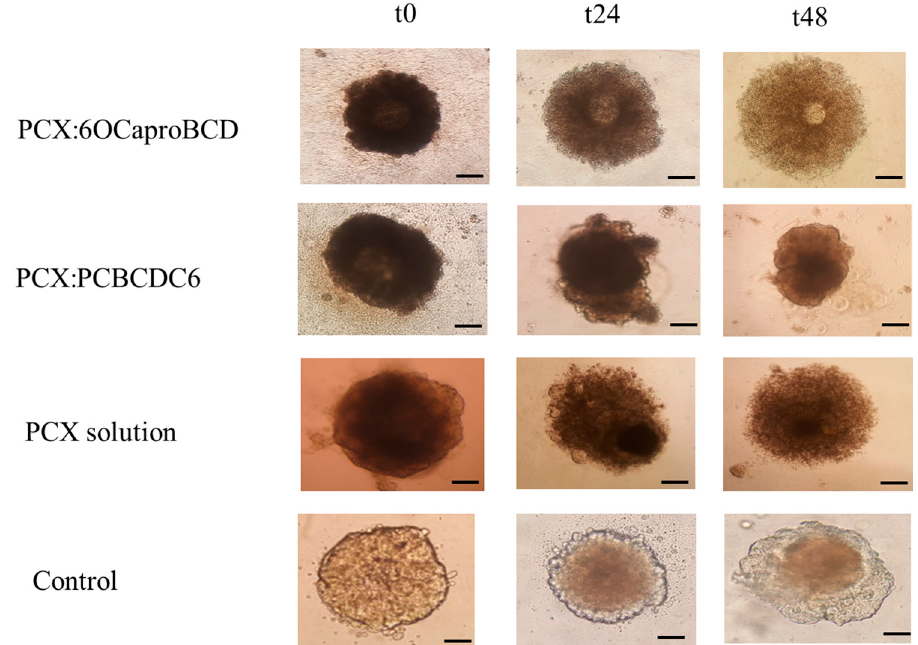
Figure 15. Time dependent microscope image of PCX:CD inclusion complex nanoparticles, PCX dilution and untreated control group. Original magnification: 10× Scale bar is 50 µm.